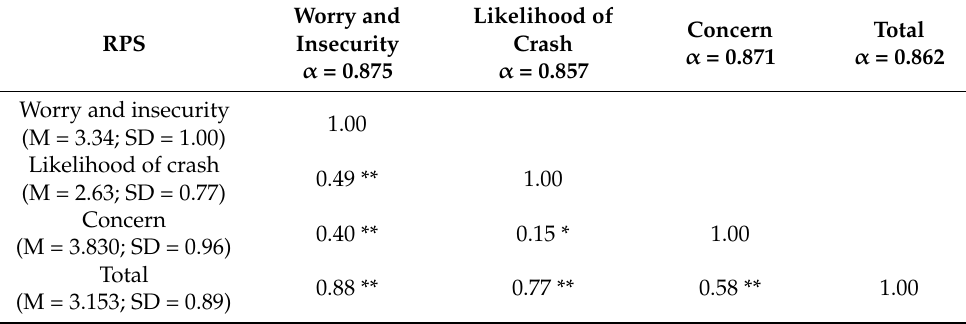
Table 8. Correlation between RPS3 subscales and aggregate